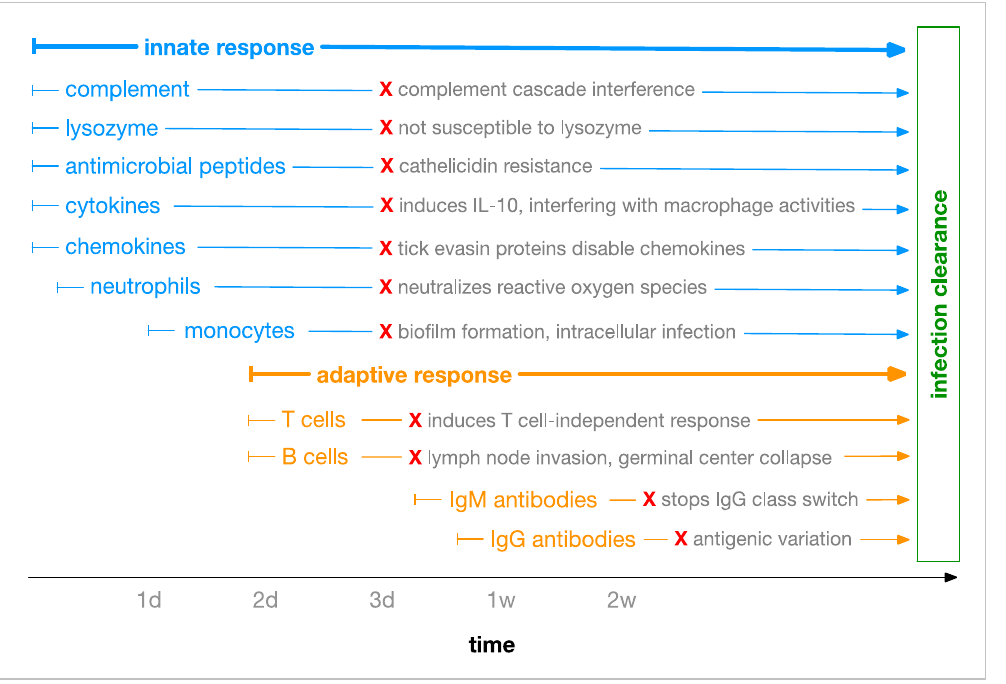
Figure 2. Borrelial Counteractions to Immune Response During Cutaneous Invasion— Borrelia evasion mechanisms counter both innate and adaptive immune responses in order to establish persistent infection in the immunocompetent vertebrate host.